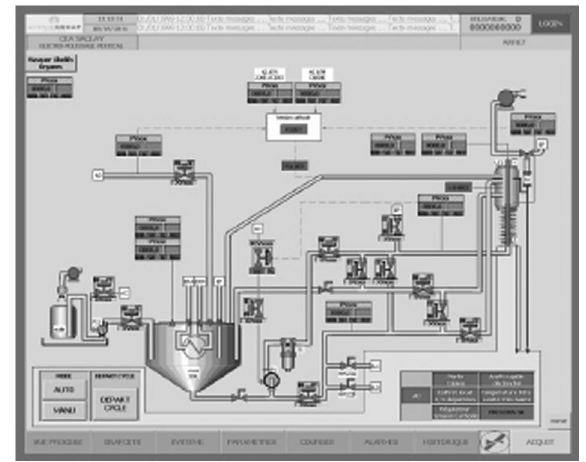
FIG. 3. (a) Insertion of the cathode in the cavity prior to (b) transfer into the EP setup.